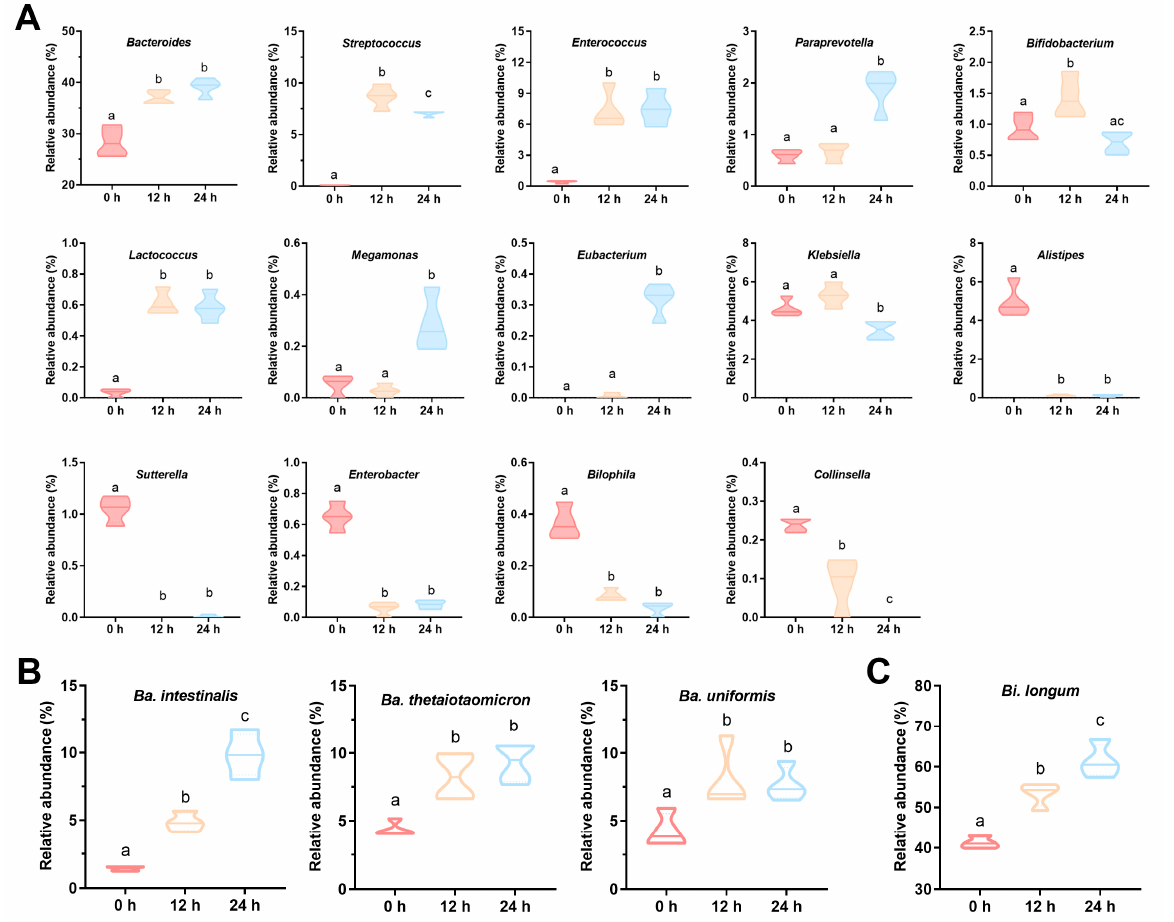
Figure 3. The effects of ABP on the relative abundances of specific gut bacteria at genus ( A ) and species ( B , C ) levels. Different letters indicate statistically significant changes among the four groups ( p <